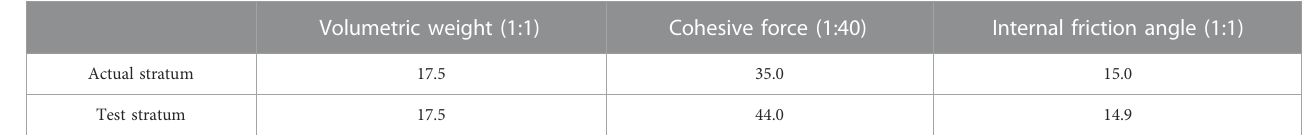
TABLE 3 Mechanical parameters of the test stratum